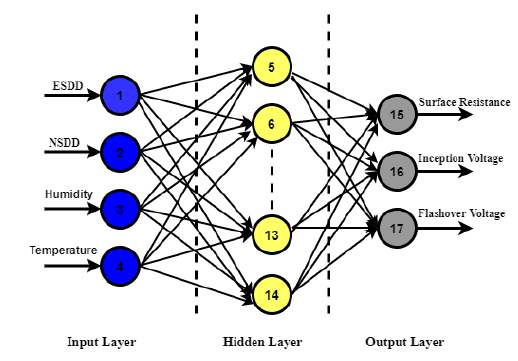
Figure 4. The proposed ANN model for flashover parameters.